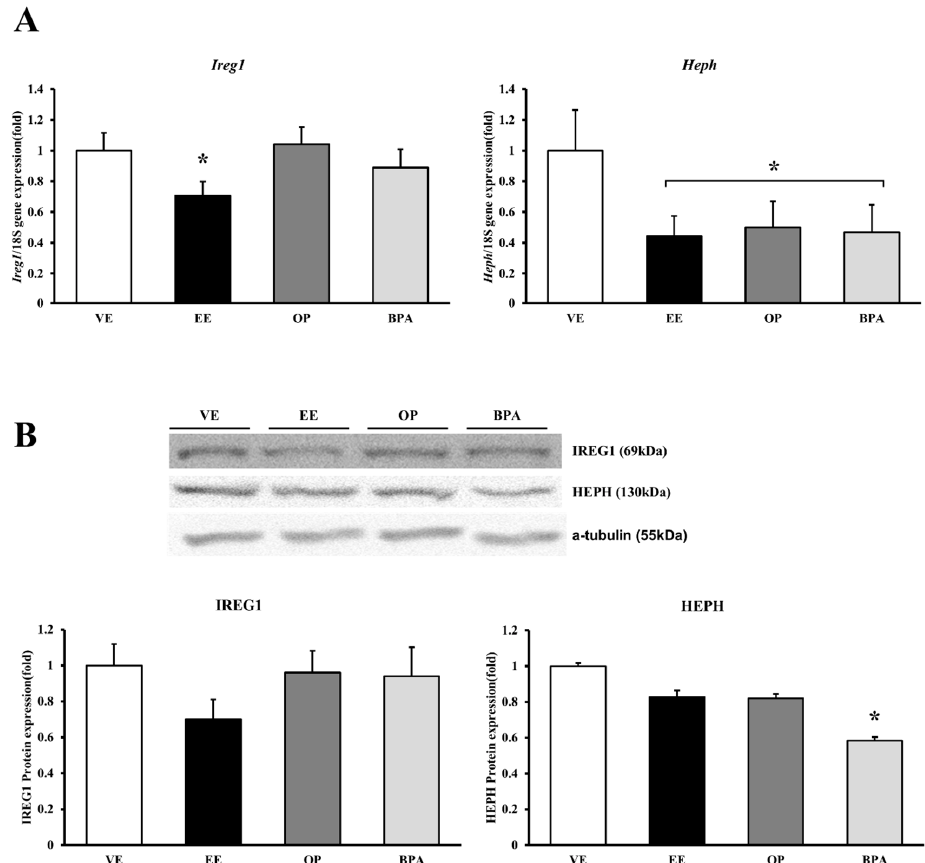
Figure 3. mRNA and protein expression of iron transporter channel in mouse placenta. The expression of calcium-transporting channel gene was examined by real-time PCR, and normalized by Rn18S . Protein expression was examined by Western blotting. mRNA expression of Ireg1 and Heph ( A ); protein expression of IREG1 and HEPH ( B ). * p < 0.05 vs. VE. Data are presented as the mean ± SD. VE DMSO 5%, EE 0.2 mg/kg, OP, BPA 50 mg/kg.